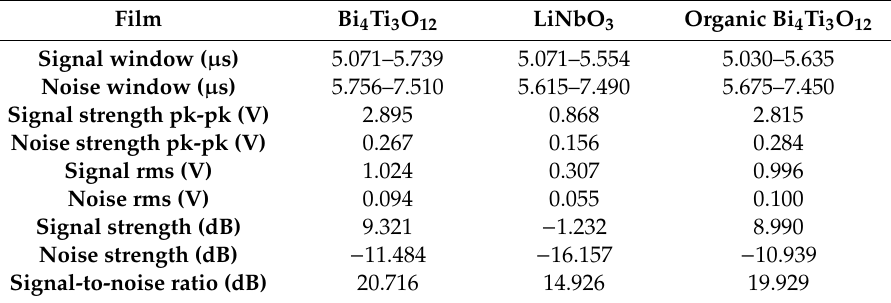
indicated [7]. indicated